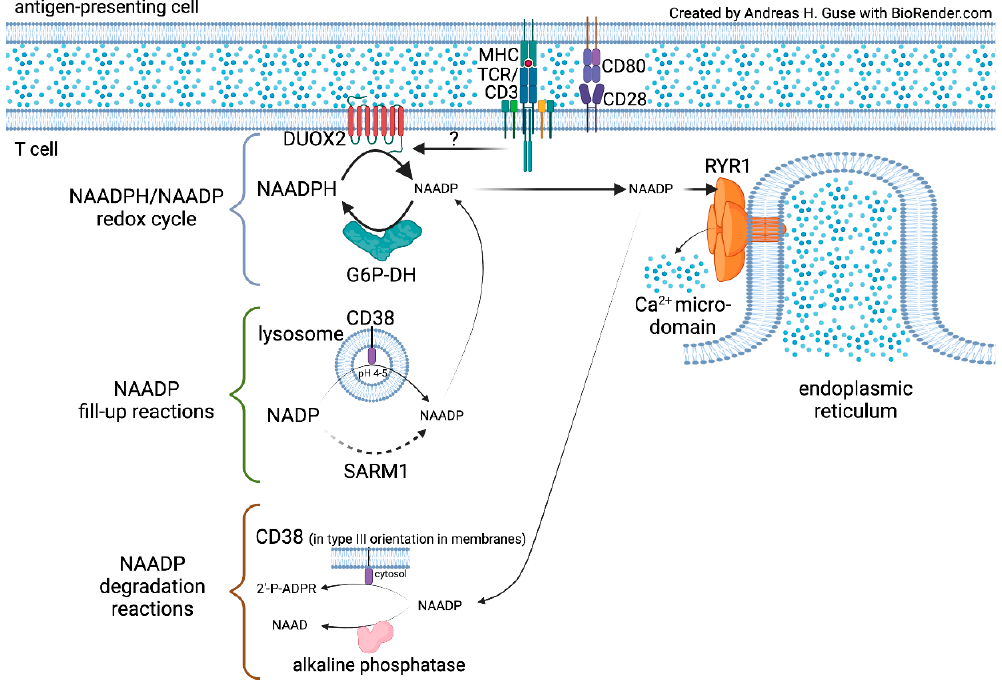
Figure 1. NAADPH/NAADP redox cycle and fill ‐ up and degradation